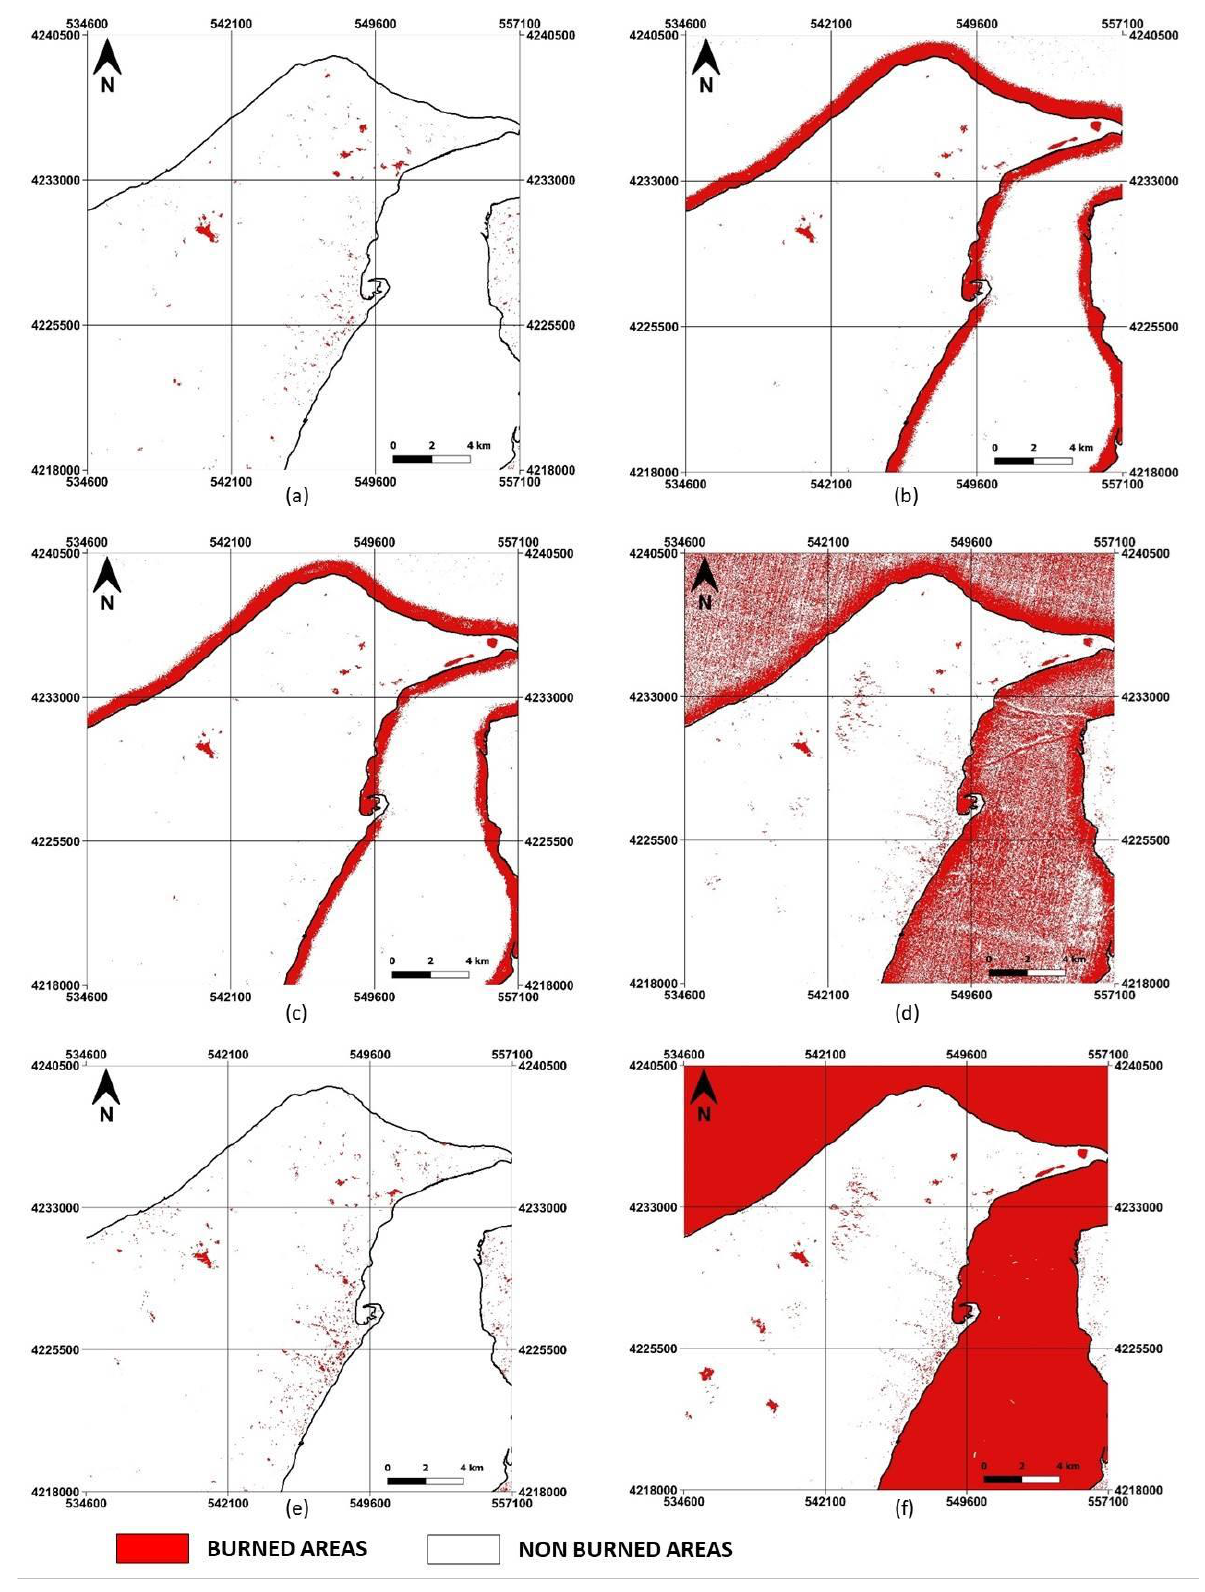
Figure 7. Maps of burned areas produced by the adopted indices using single-date approach: